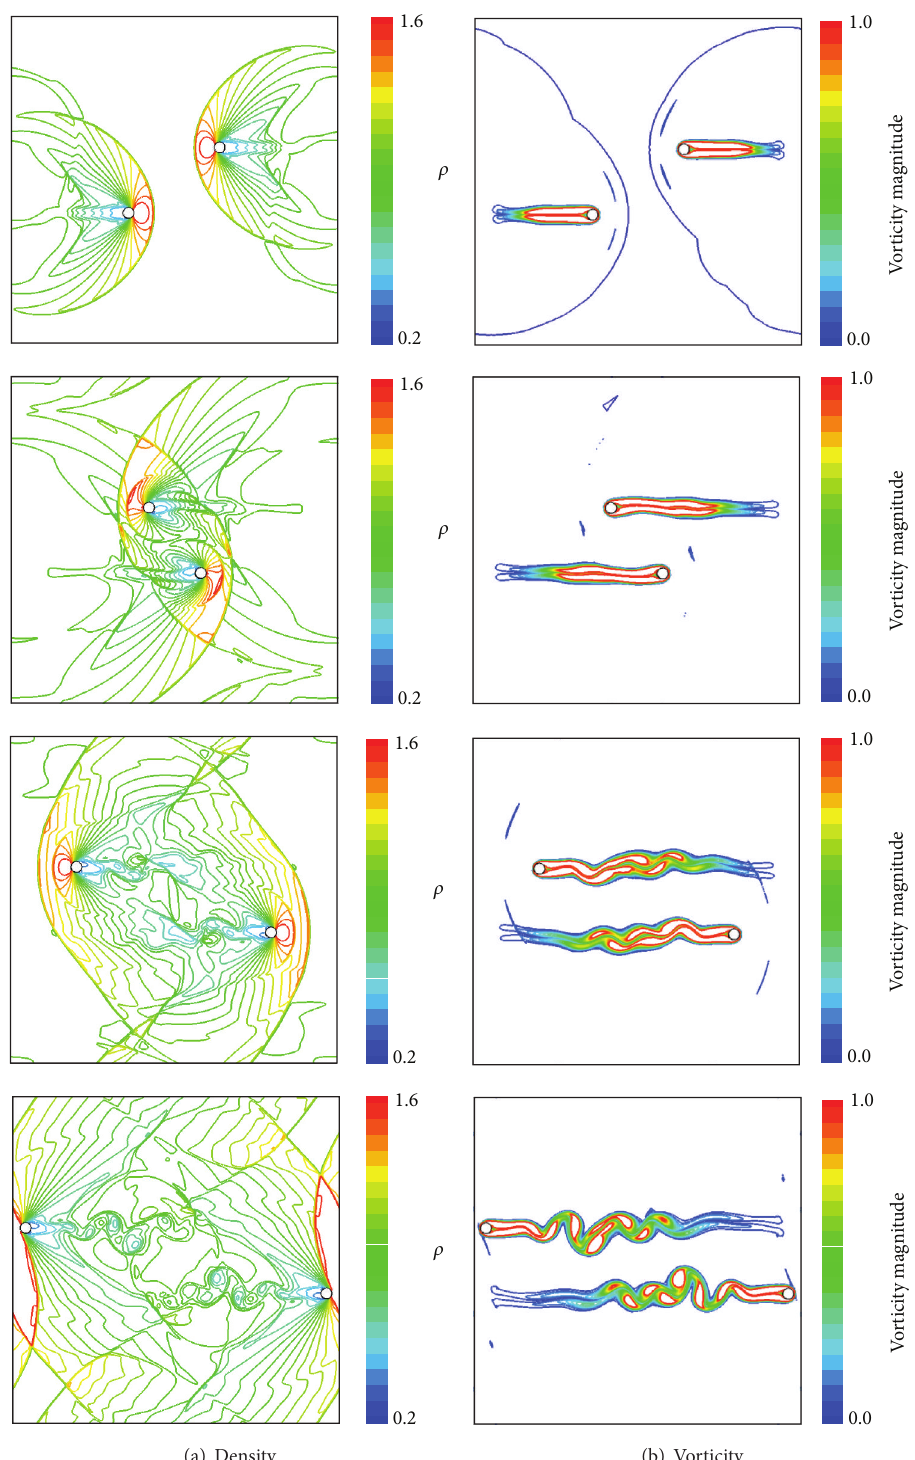
Figure 20: Density and vorticity contours at nondimensional times = 8.2, 13.6, 19.1, and 23.2 with 𝑑𝑥 = 0.025 𝐷